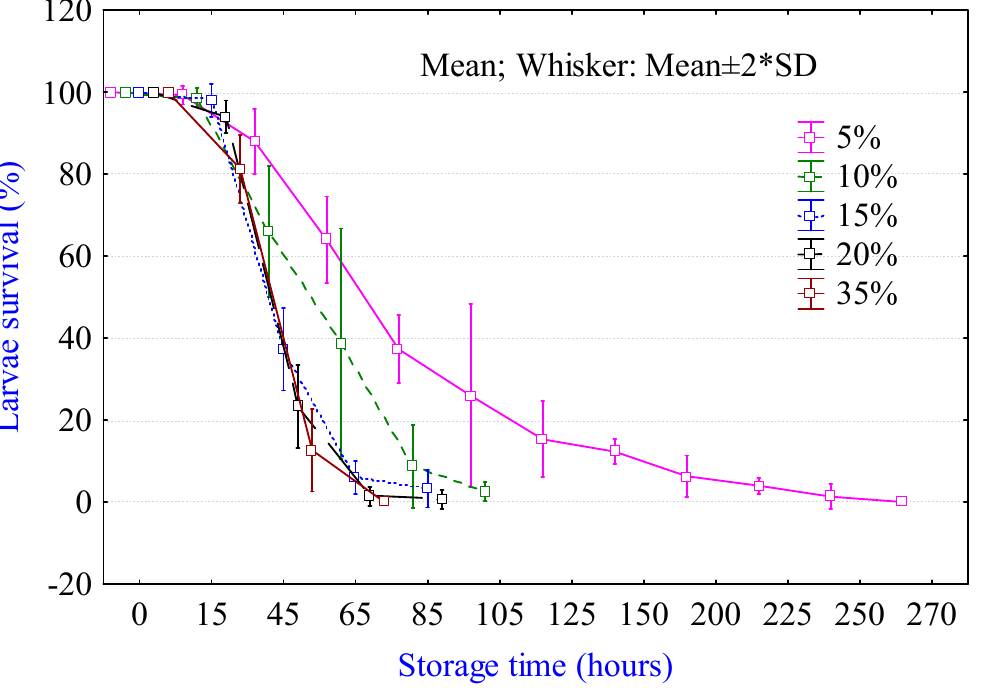
Figure 1. Survival of Anisakis spp. larvae exposed directly to different NaCl solutions (5, 10, 15, 20, and 35 g/100 mL).